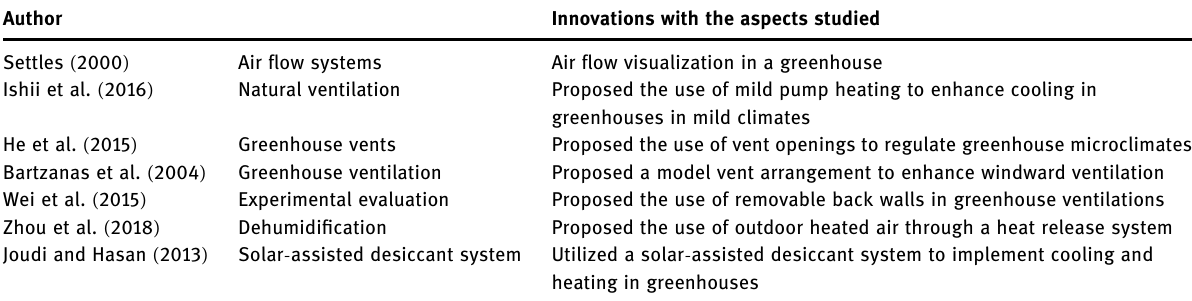
Table 1: Reviewed articles, approaches, and parameters